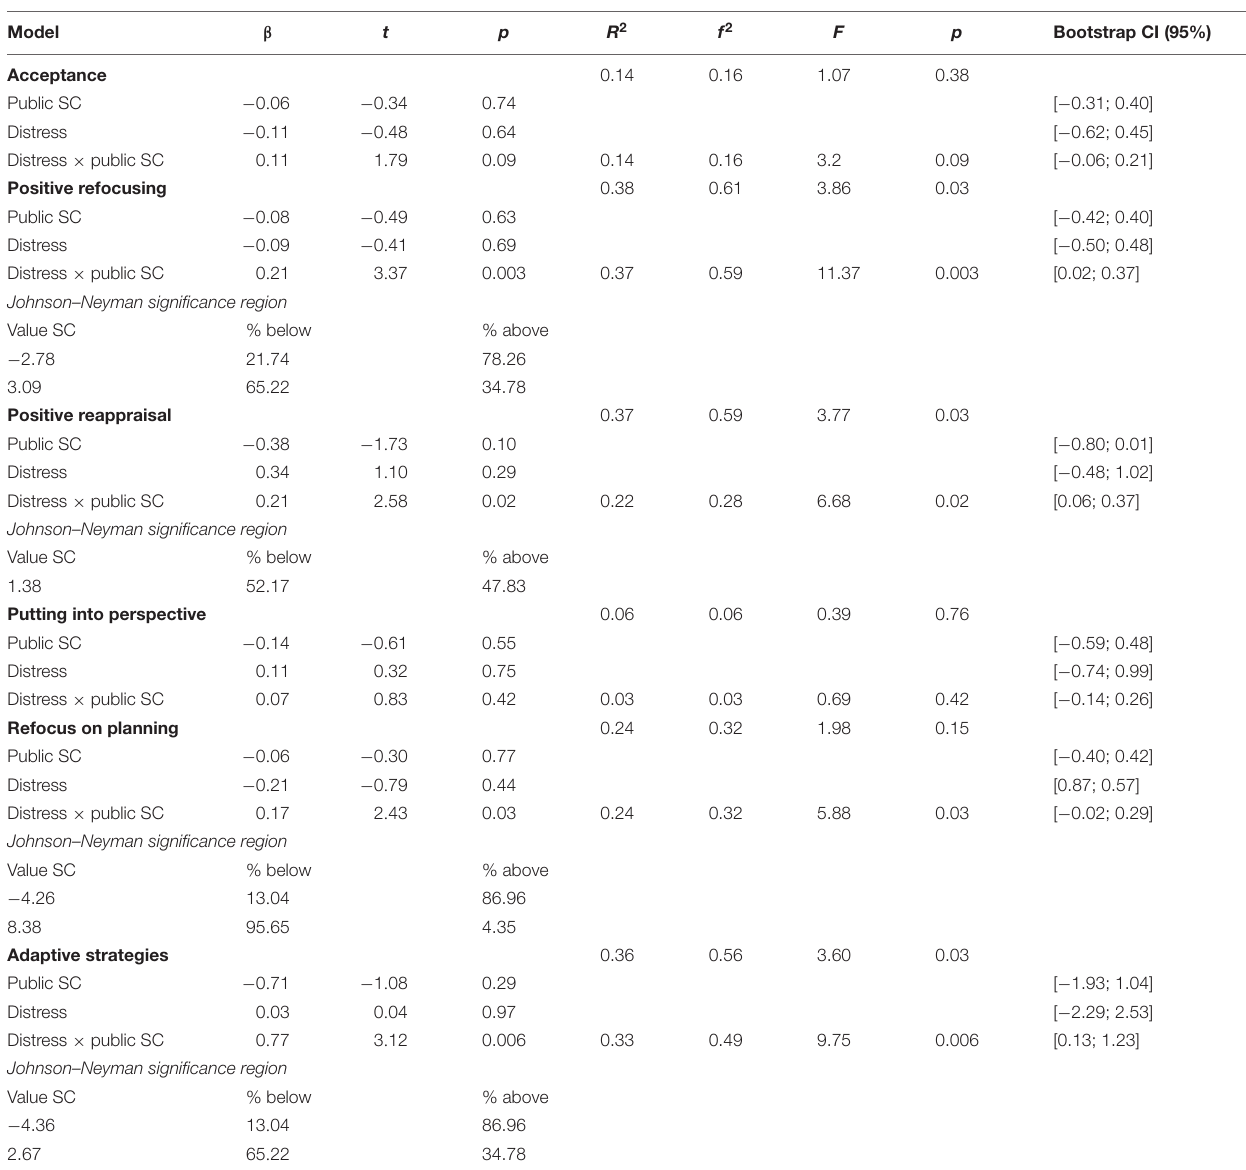
TABLE 10 | Multiple regression analyses predicting adaptive emotion regulation strategies as a function of public SC, distress and their interaction in the control group.